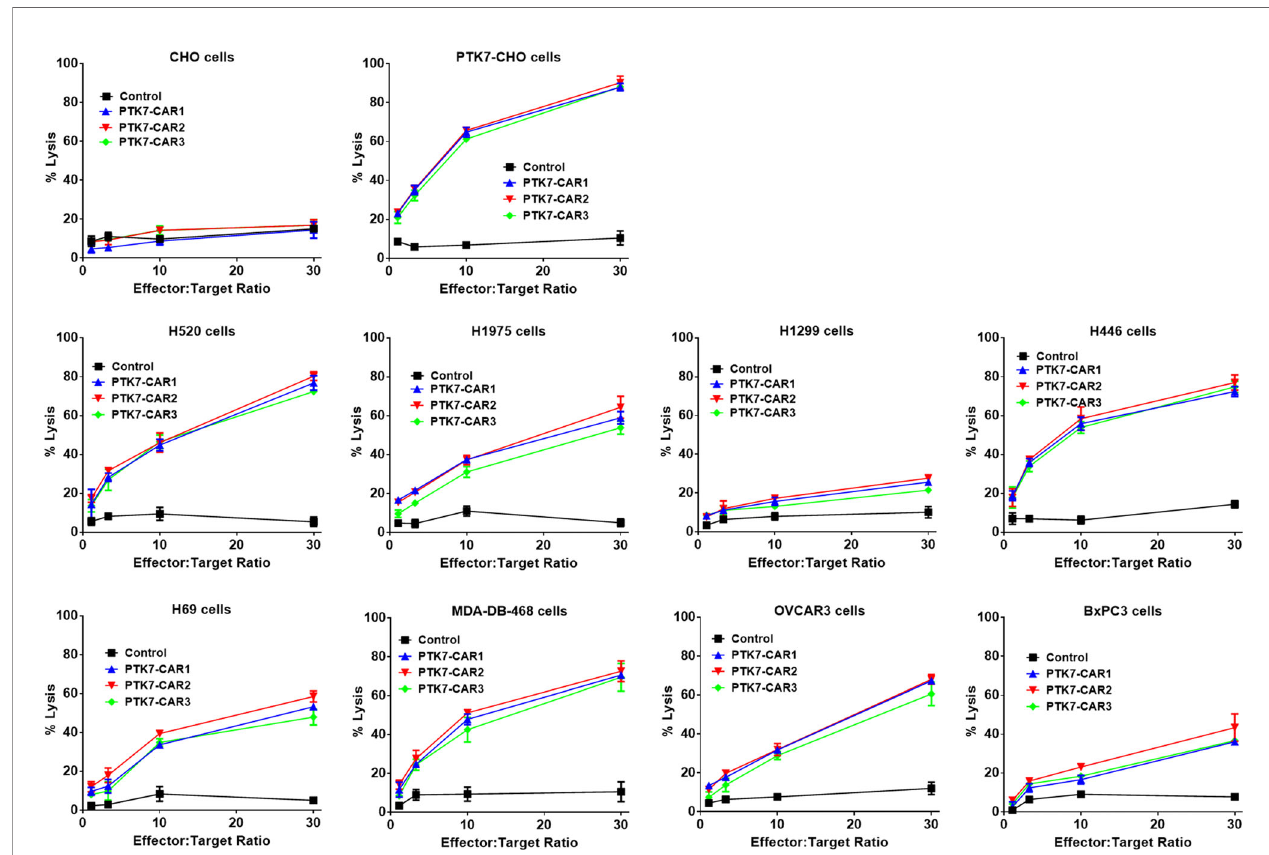
FIGURE 4 | PTK7-CAR T cells kill PTK7-positive tumor cell lines. GL-expressing tumor target cells were co-cultured with control or PTK7-CAR T cells at the varying effector-to-target ratios in triplicate wells of white 96-well plates. Target cell viability was monitored 18 h later by using Bright-Glo ™ Luciferase Assay System according to the manufacturer ’ s instructions. The percent lysis (%) was calculated by using the following equation: 1-[bioluminescence value in sample well (target cells + CAR T cells)/maximum bioluminescence value (target cells alone)]. Shown are means ± SEM of % cell killing in triplicate